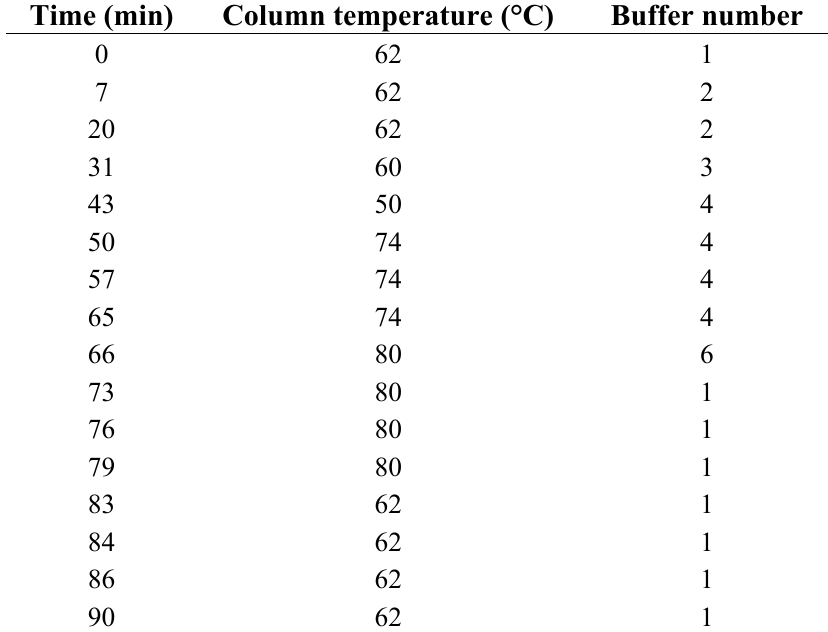
Table 5. Chromatographic